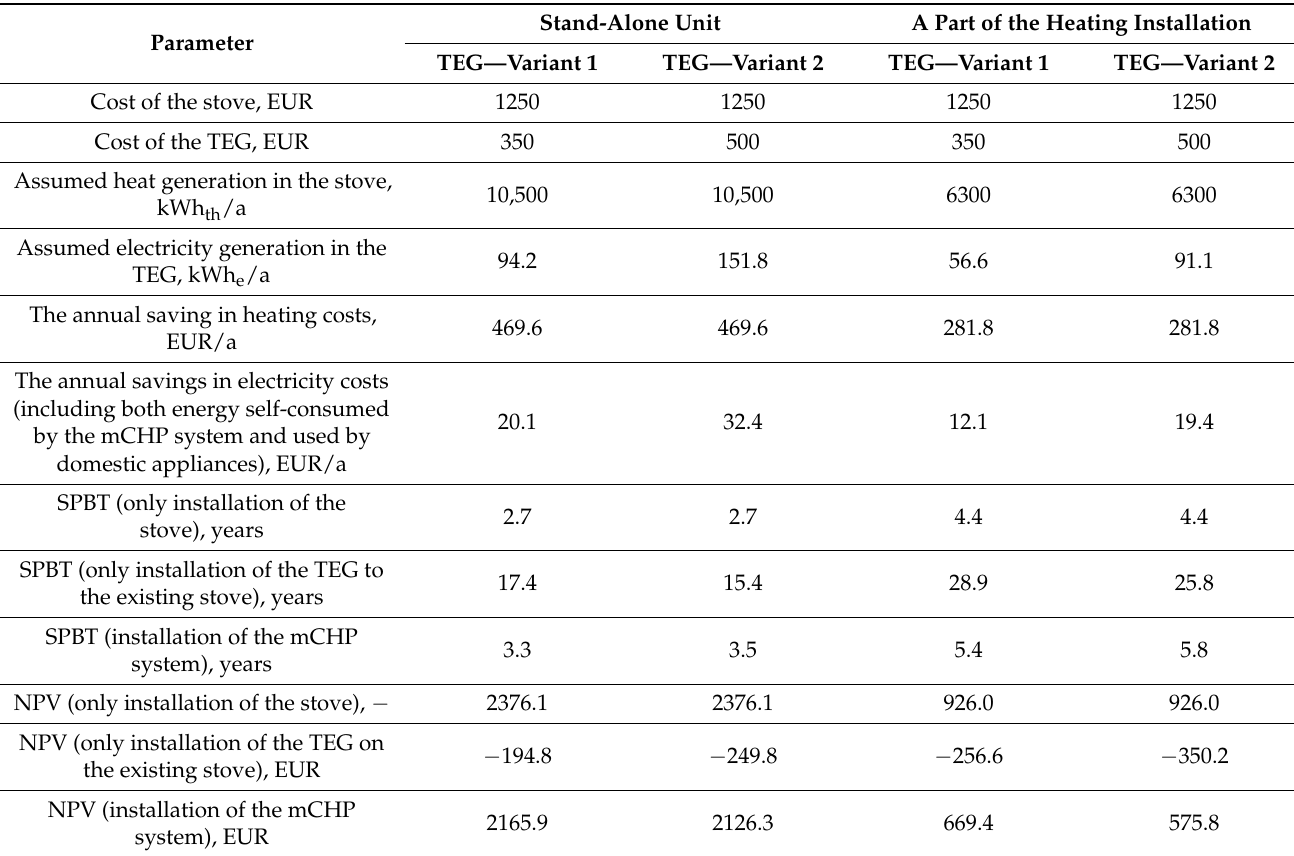
Table 4. Economic analysis of the proposed mCHP